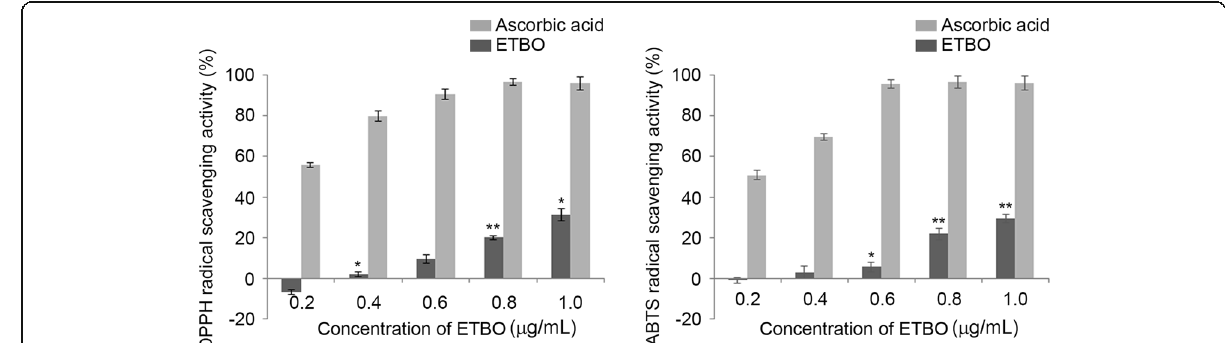
Fig. 1 Antioxidant activities of ETBO: DPPH and ABTS assays. Quantitation of the results from three independent experiments ( n = 3) is shown as the mean ± SD. * p < 0.05 and ** p < 0.01 between the control and ETBO-treated group. ETBO, Ethanol extract of Botryidiopsidaceae sp.; DPPH,